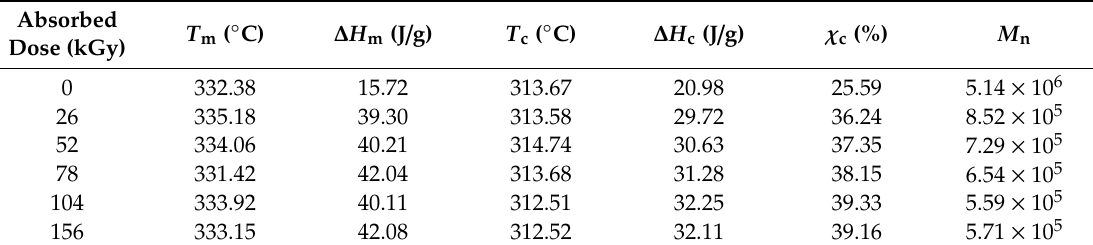
Table 2. Thermal properties of PTFE with 40% bronze, in its initial state and after electron beam